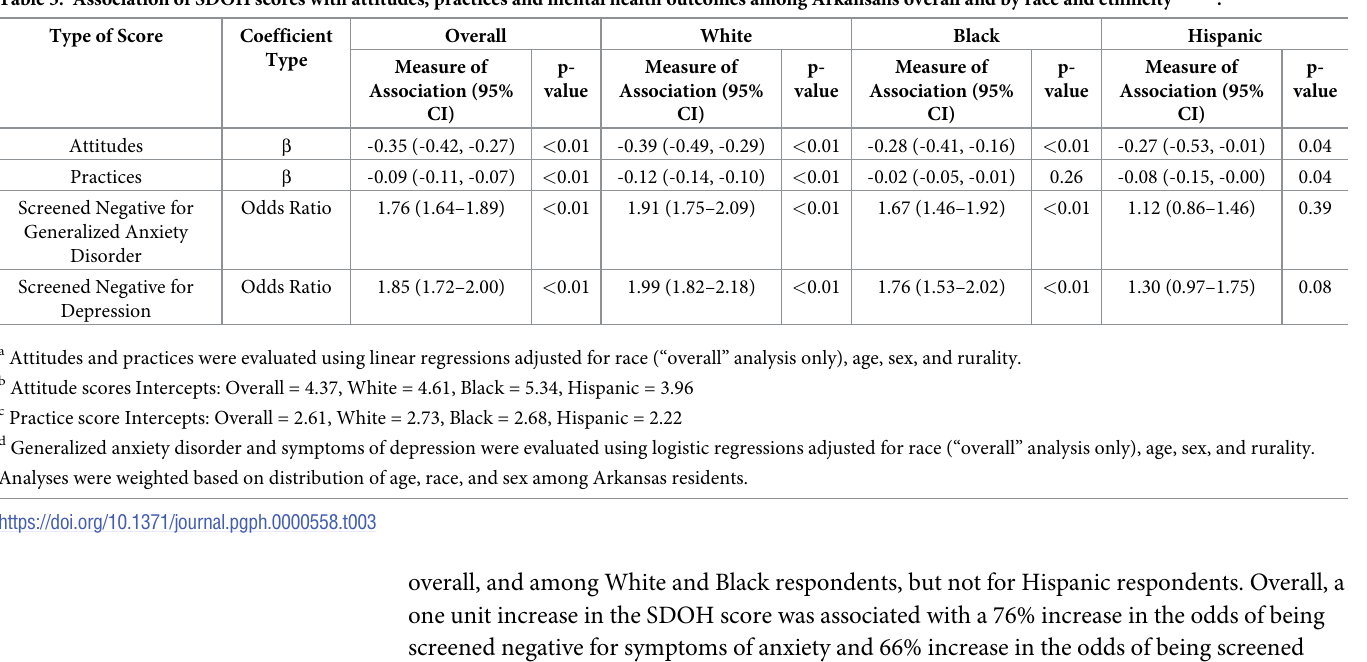
overall, and among White and Black respondents, but not for Hispanic respondents. Overall, a one unit increase in the SDOH score was associated with a 76% increase in the odds of being screened negative for symptoms of anxiety and 66% increase in the odds of being screened negative for depressive symptoms. SDOH scores were associated with increased odds of screening negative for anxiety and depression among White (aOR:1.91; 95%CI: 1.75,2.09 and